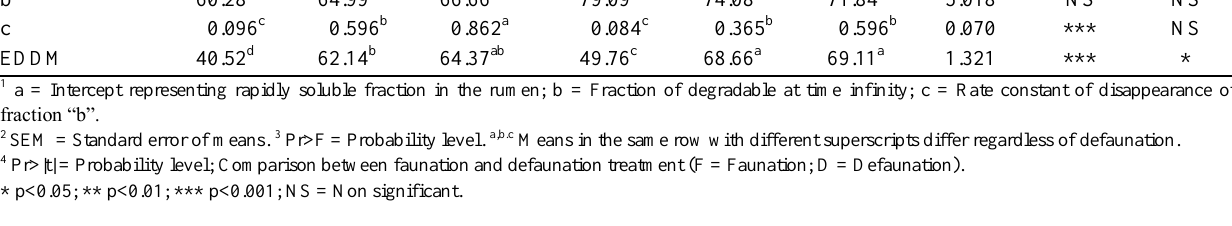
Table 3. Degradation parameters (a, b, and c) and effective degradability (ED) DM of the experimental diets in the culture solution as influenced by faunation or defaunation when incubated with different cereal grains Treatment Parameters 1 Faunation Defaunation and EDDM Corn Wheat Rye Corn Wheat a